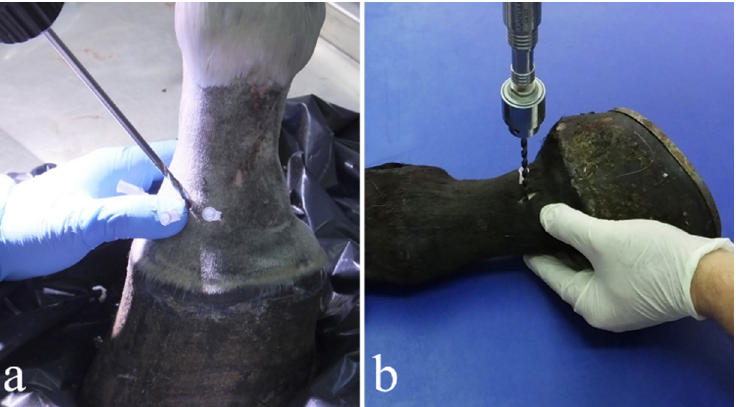
Figure 1. Dorsal ( a ) and lateral ( b ) drilling approach. The articular space was identified by the insertion of a series of hypodermic needles at a distance of 1 cm from each other.